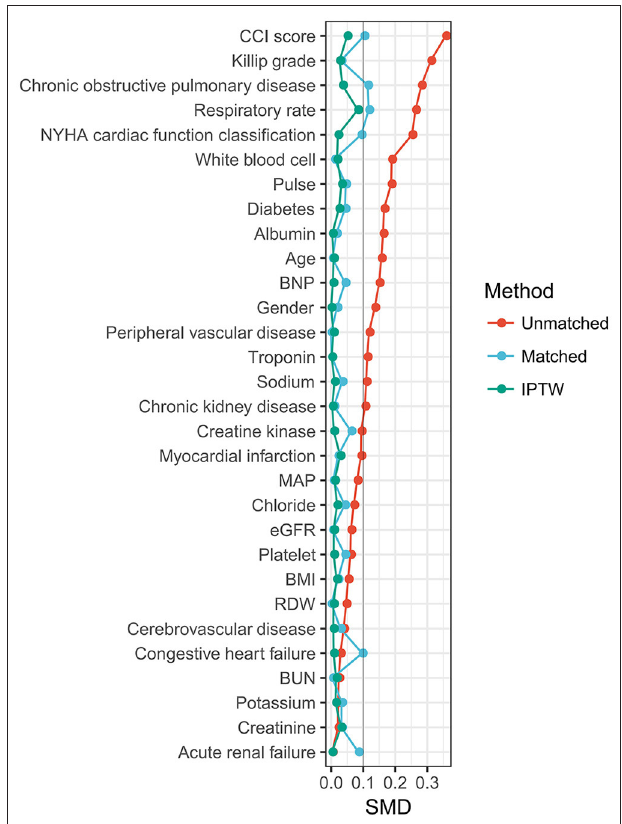
FIGURE 2 | Relative influence factor of covariates. The relative influence factor measures how discriminative the 30 covariates of the propensity score model are when predicting the likelihood of ABG performance.